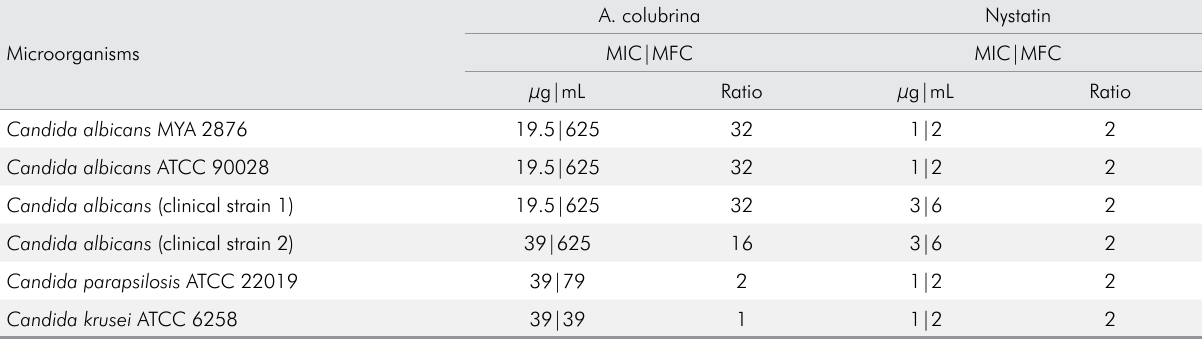
Table. Distribution of minimum inhibitory concentrations (MIC) and minimum fungicidal concentrations (MFC) of A. colubrina extract, for the Candida